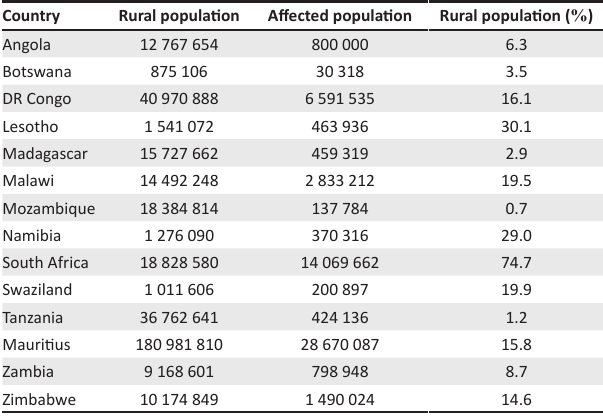
TABLE 1: Southern African countries’ rural populations affected by 2015 drought. Country Rural